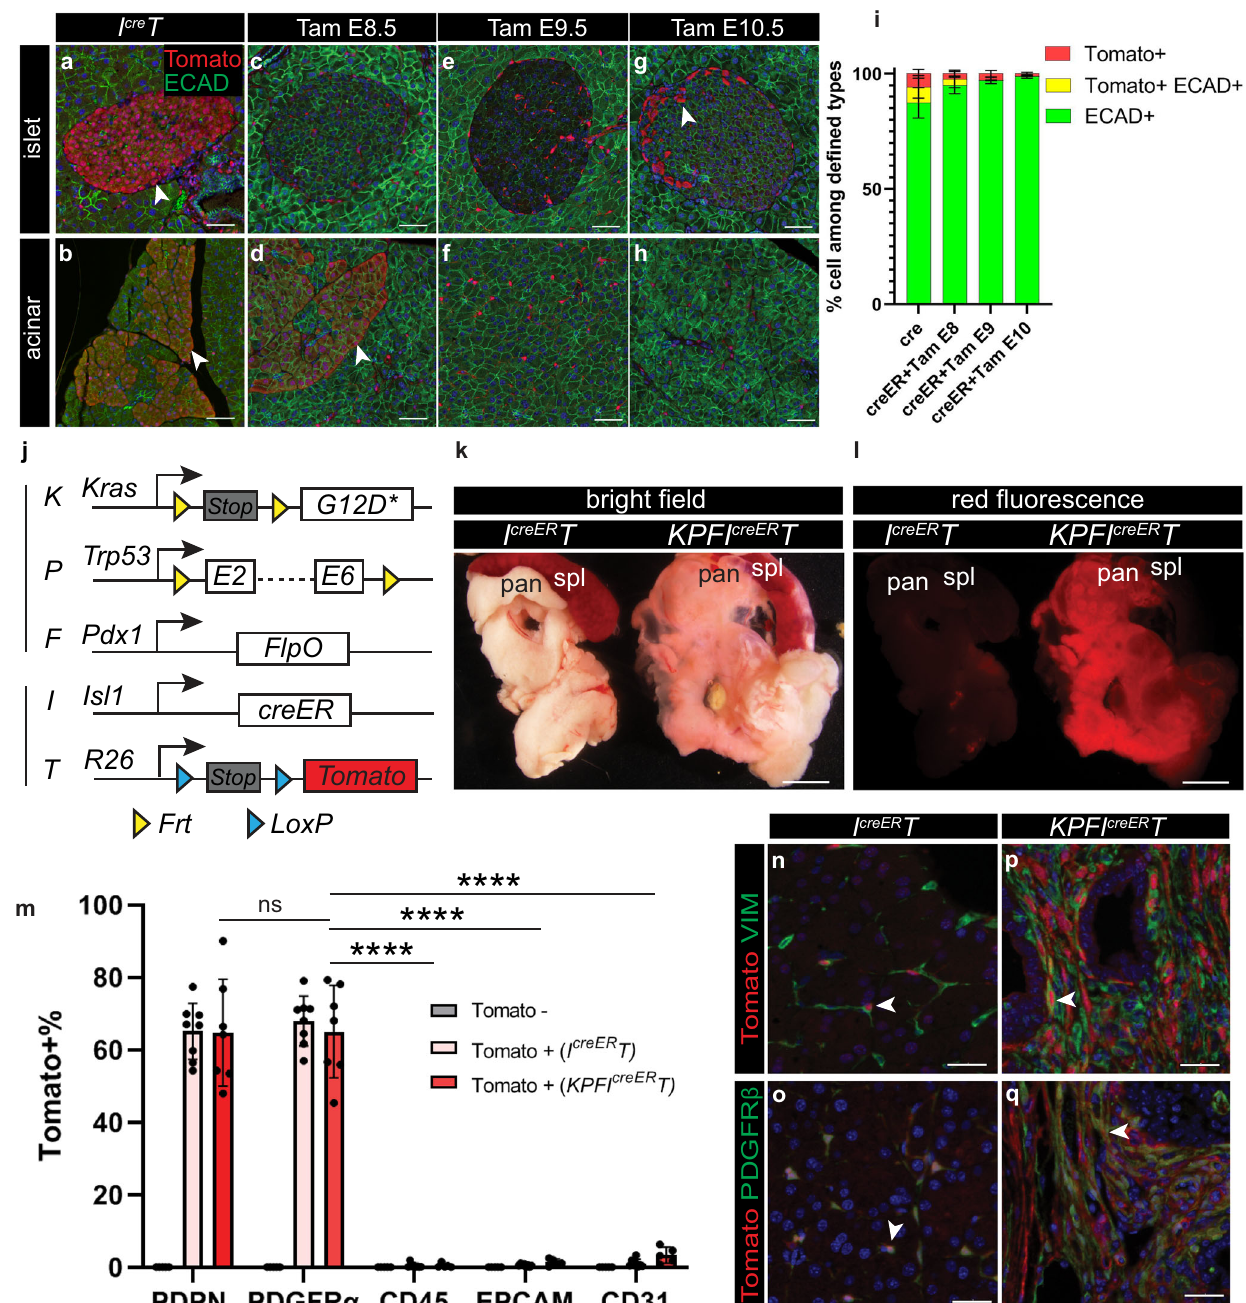
Fig. 4 | KPFI creER T model speci fi callytargets fi broblasts inthe pancreas. a – h Co- immunostaining of pancreatic tissues (focusing on either the islet region or the acinar region) comparing the I cre T model and the I creER T model treated with Tamoxifen at indicated times points. Arrowheads denote Tomato+ epithelial cells. i Quanti fi cationofcellsthatareeithersinglepositiveordoublepositiveforde fi ned markersinimagesrepresented in( a – h ). I cre T , n =5mice; I creER T +Tam E8, n =5mice; I creER T +Tam E9, n =6 mice; I creER T +Tam E10, n =4 mice. j Schematic the KPFI creER T mousemodel. k , l Bright fi eldandredepi fl uorescenceviewsofdissectedpancreata and spleens. I creER T , n =6 mice; KPFI creER T , n =7 mice. m Quanti fi cation of